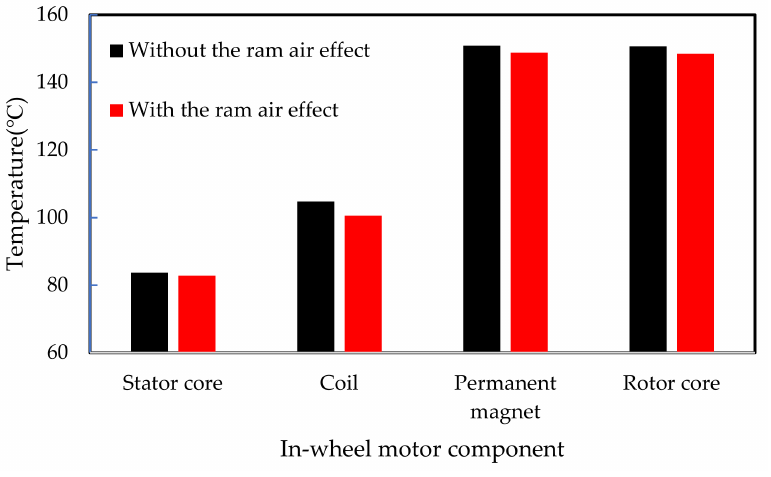
Figure 9. Comparison of average temperature of major parts of in-wheel motor considering the ram air